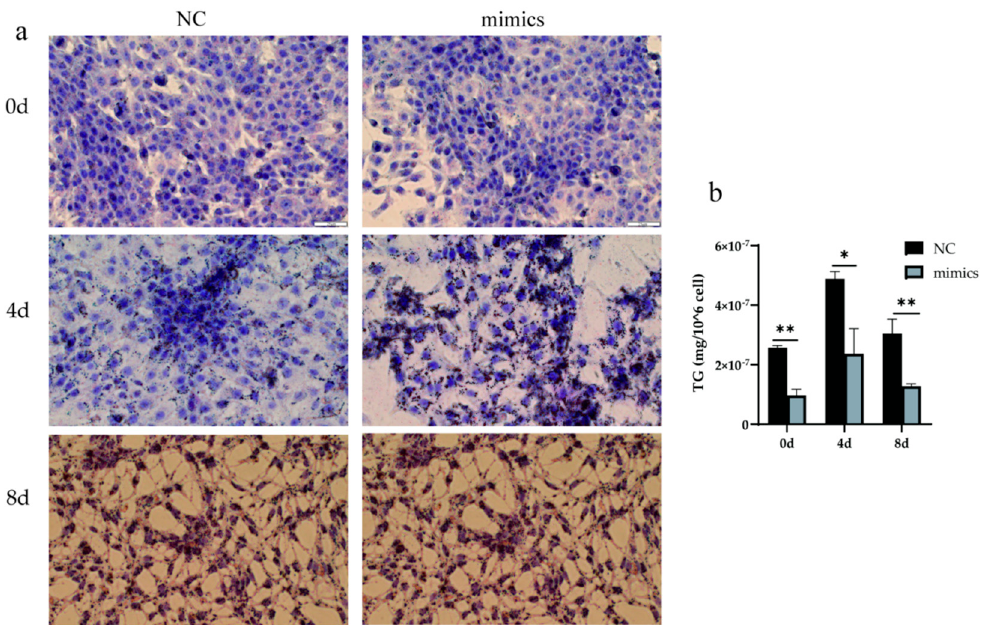
Figure 7. Overexpression of xeno-miR168b inhibited lipid droplet formation ( a ) and decreased TG content ( b ) in BMECs. Data are given as the mean ± SD for n = 3/group. * p < 0.05 or ** p < 0.01 was considered statistically significant.